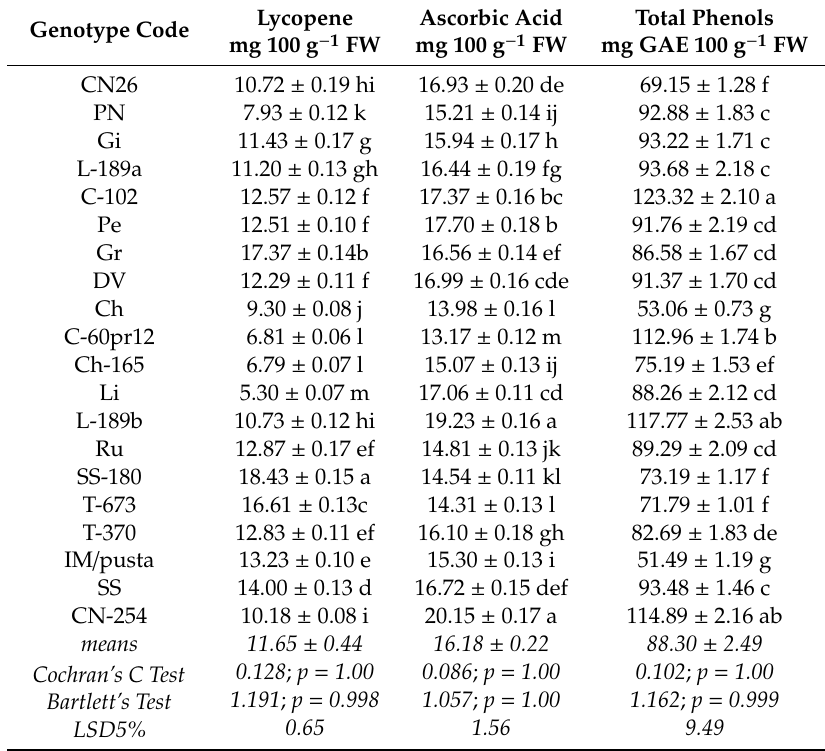
Table 3. Lycopene (Lyc),ascorbic acid (AsA),and total phenolic content (TPC)of tomato fruit